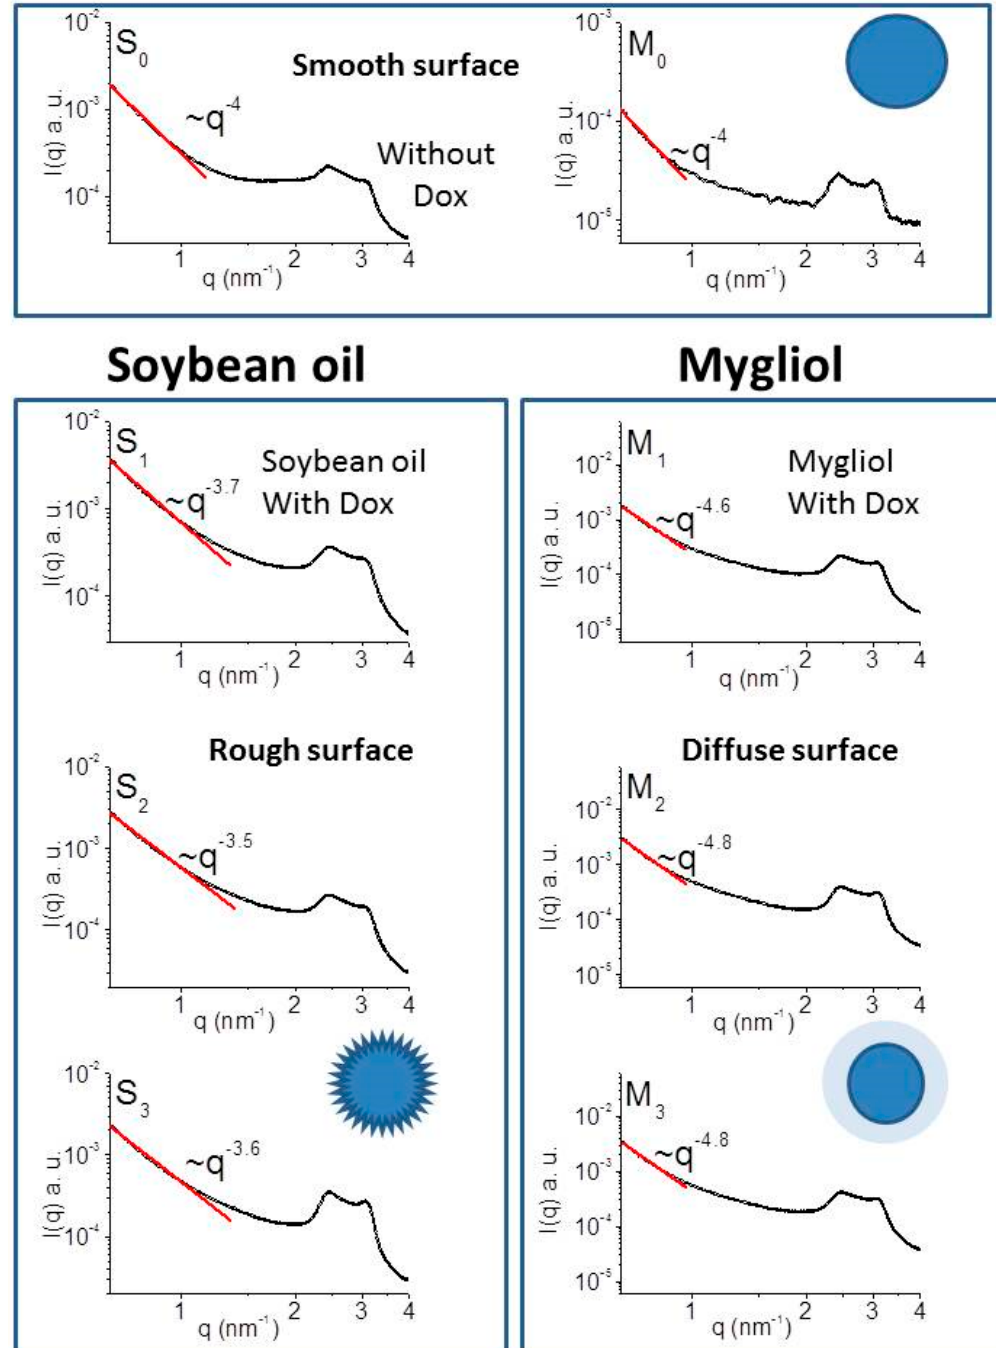
Figure 6. Loading with Dox abrades the surfaces of STS-containing soybean oil carriers. Shown here are the results of SAXS measurements using STS-containing Mygliol 812 (M) and Soybean (S) oil-based carriers with S0 and M0 denoting plain formulations, and Dox-loaded carriers labeled with the amounts of Dox loaded (M1: 180 µ M; S1: 360 µ M; M2 and S2: 540 µ M; M3 and S3: 900 µ M). The intensity of the scattering event I is plotted using arbitrary units against the scattering vector q in nm − 1 with the approximated tangent of the graph denoted as red line in the respective plots. In addition, a graphical interpretation of the results obtained is provided. Both plain soybean oil and plain Mygliol 812-based systems display a smooth surface in accordance with [30]. Loading with Dox, regardless of the amounts loaded, roughens the surface in the case of soybean oil carriers. In stark contrast, Mygliol 812-based formulations yield a diffuse surface after loading with Dox.